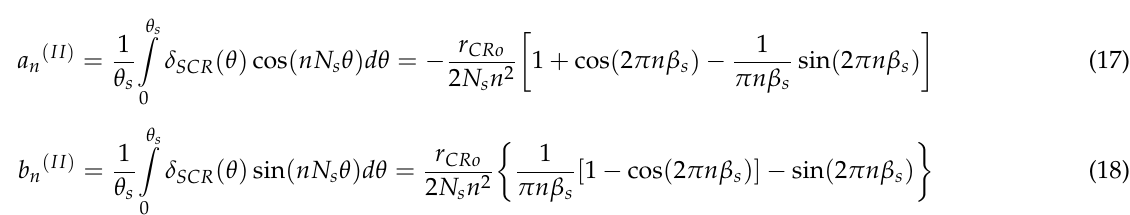
The analytical and FEA results of model − A to model − D are compared clearly in Figure 5. The permeance distribution of model − A is approximately linear, because its equivalent air-gap is uniform. The number of trough and flat-top wave heads of the permeance distribution of model − B is the same as the number of slots and teeth of the CR, respectively. The troughs of model − C are equal to the permanent magnet poles. The trough number of permeance distribution in model − D is in one-to-one correspondence with the number of PM poles and of CR slots. The analytical results of the permeance models are in good agreement with the FEA results, which also verifies the reliability of the proposed analytical permeance model.